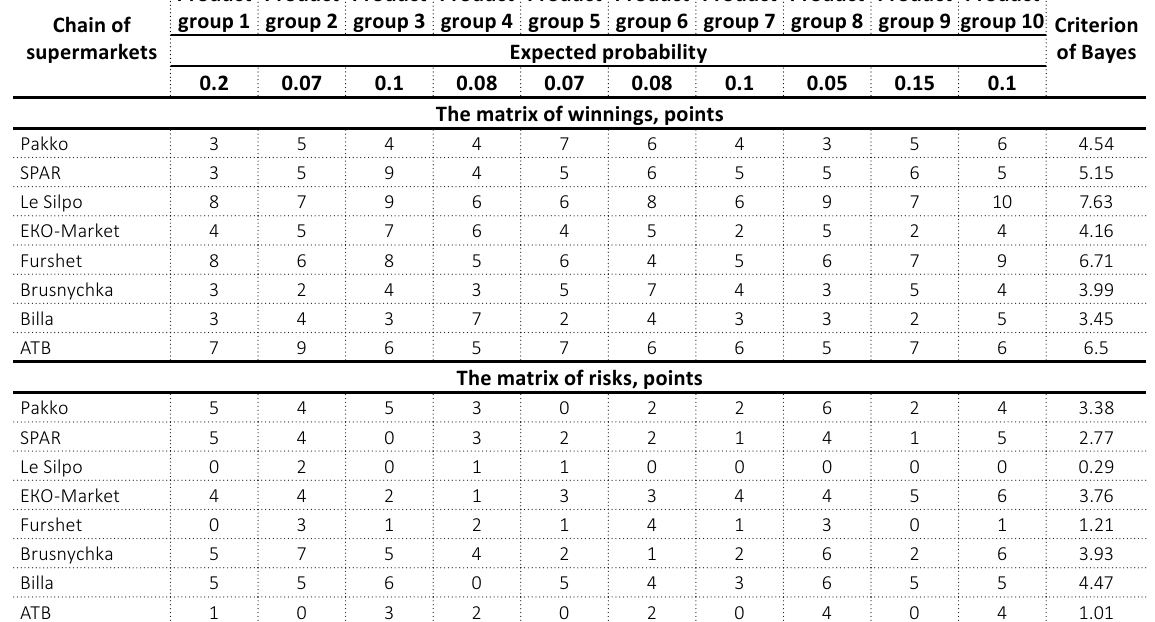
Source: Developed by the